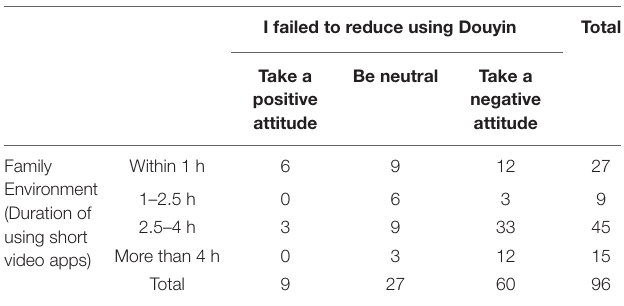
TABLE 3 | Cross-sectional analysis of family environment and addiction